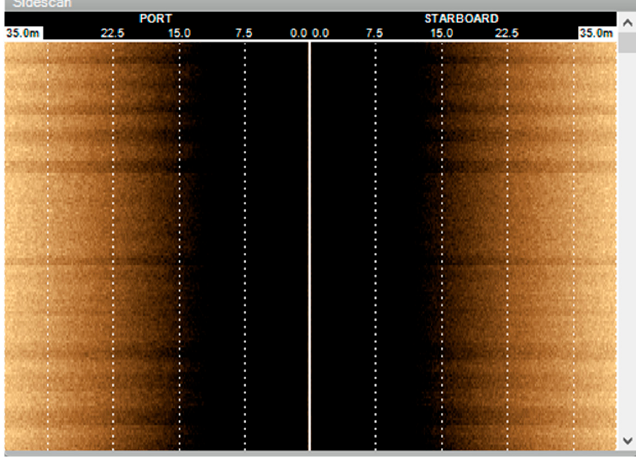
Figure 7. Sonar image with cables routed closely.